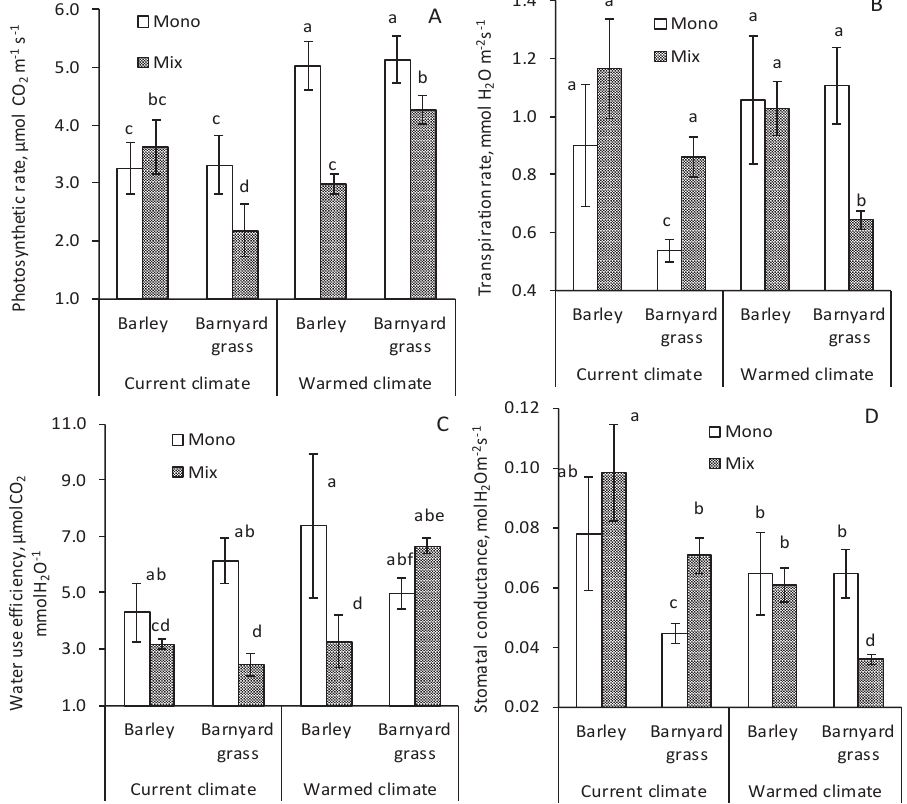
Fig. 2. The changes in photosynthetic rate (A), transpiration rate (B), water use efficiency (C), and stomatal conductance (D) in barley ( Hordeum vulgare L.) and barnyard grass ( Echinochloa crus-galli L.) plant leaves grown in mono culture (Mono; 15 plants per pot) and mix culture (Mix; 9 crop plants and 6 weeds) at current (400 µmol mol -1 CO ; day/night temperatures 21/14 °C) and a warmed (800 µmol mol -1 CO 2 °C) climate conditions. Each value represents the mean ±CI (n=3). Different letters indicate significant differences at p <0.05 between the treatments as determined by Least Significant Differences (LSD)